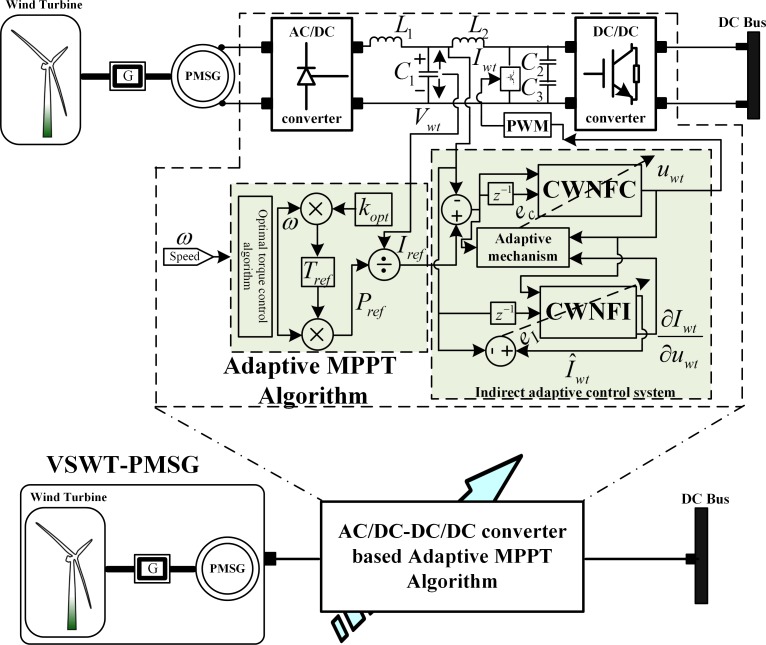
VSWT-PMSG subsystem closed-loop model.